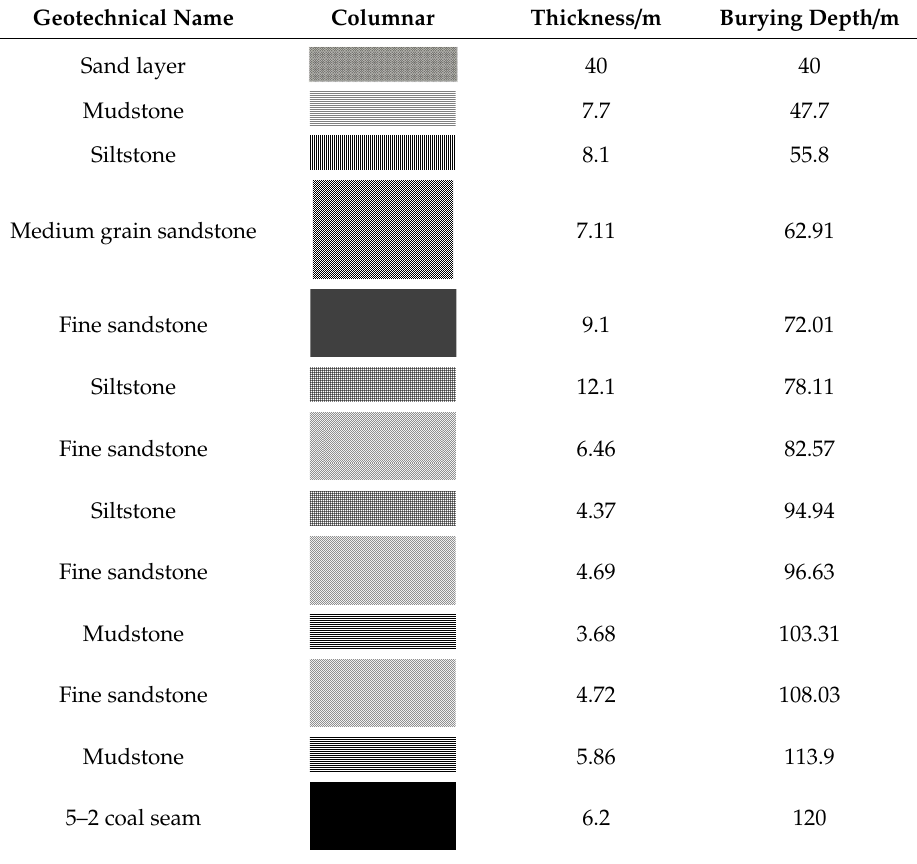
Table 1. Lithology of the no. 12401 working face.